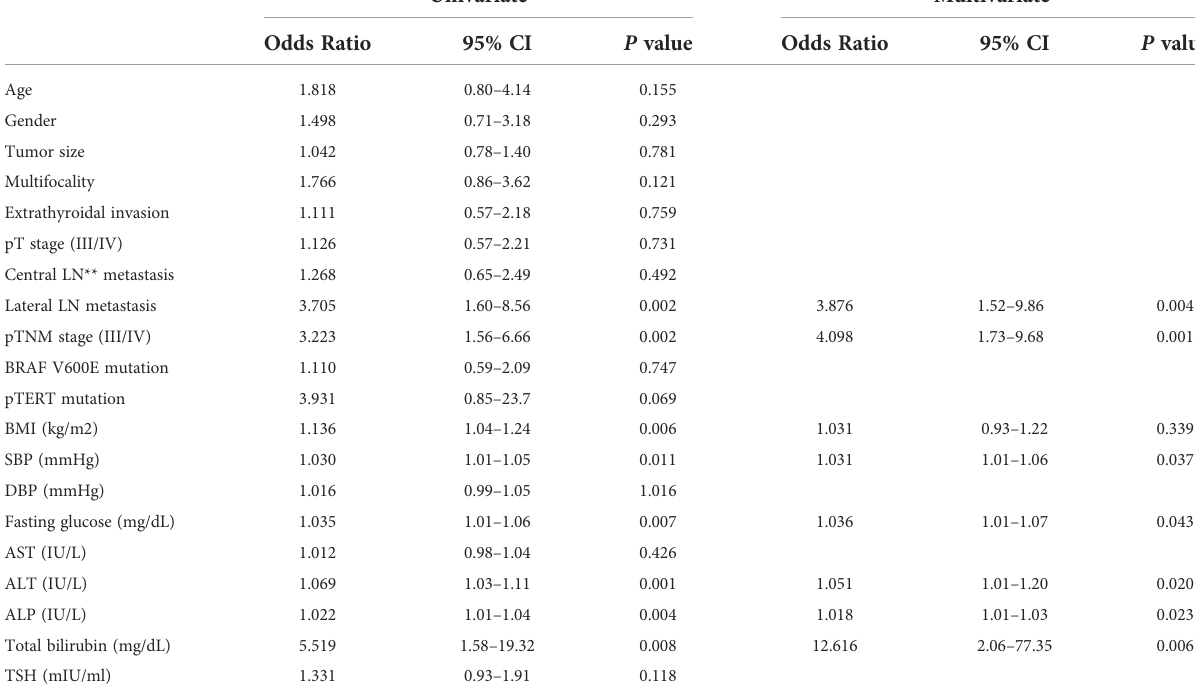
TABLE 2 Univariate and multivariate analyses identifying the clinico-pathological parameters that show independent correlation with serum GDF15 level.